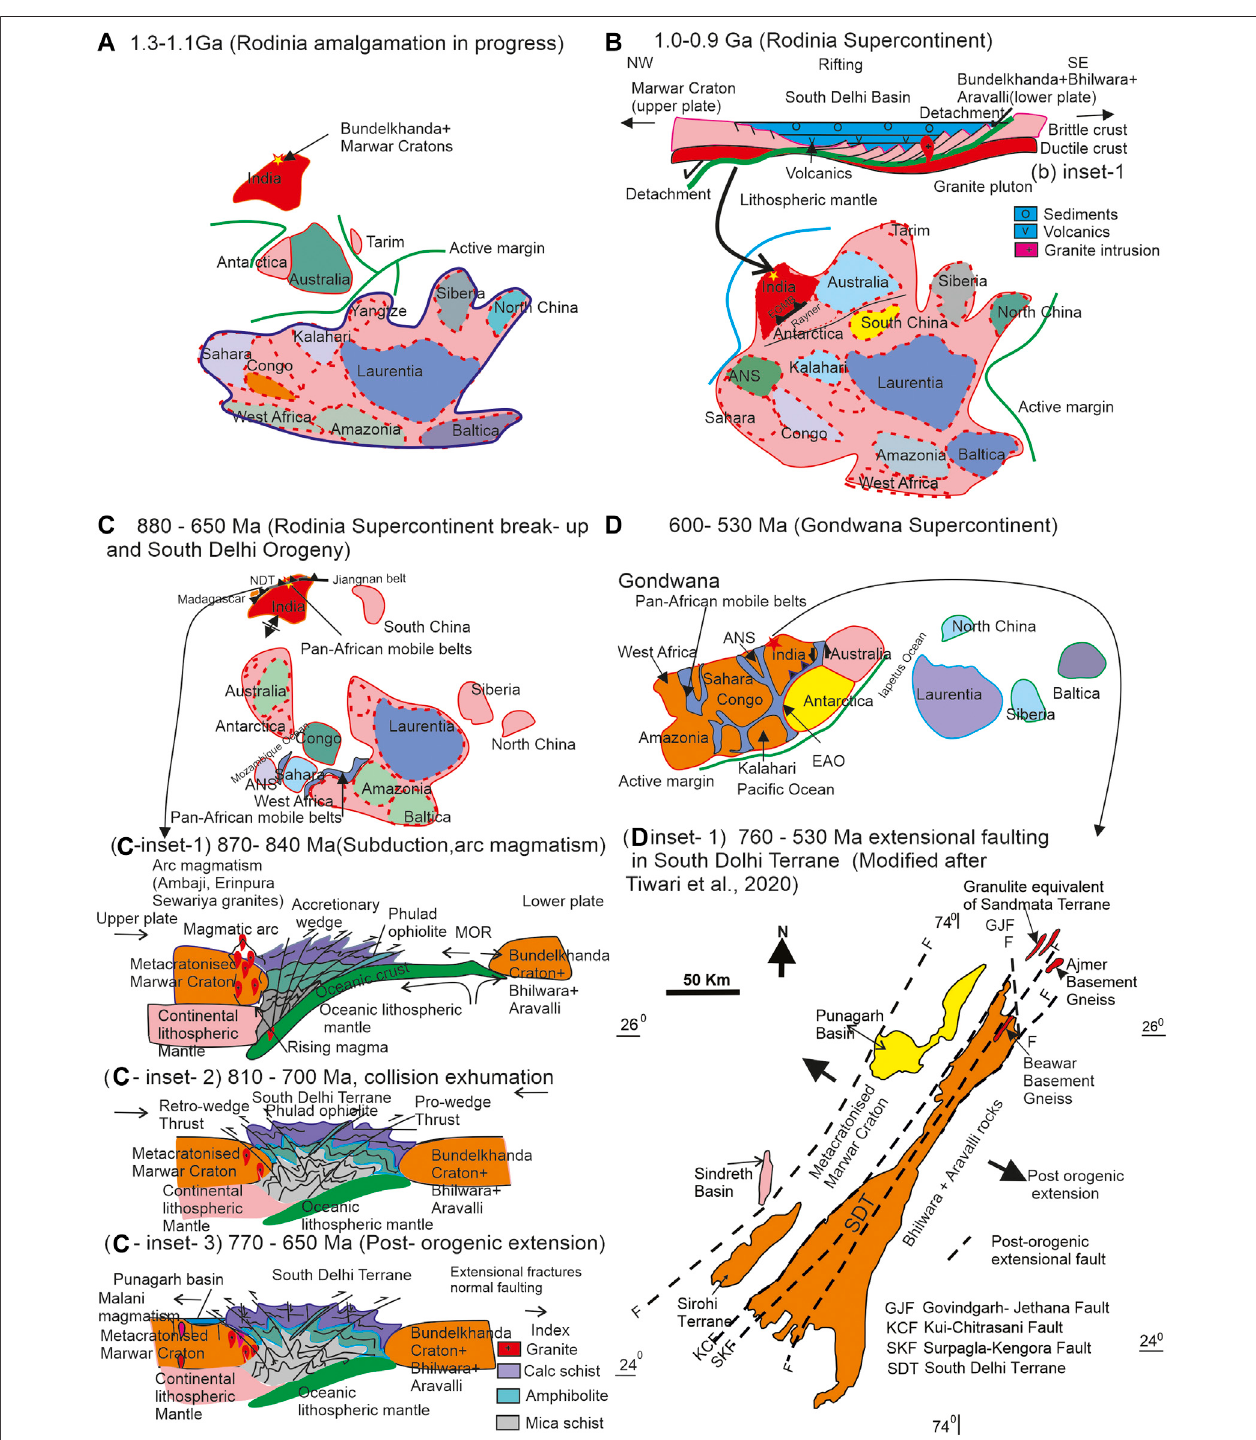
FIGURE10| CartonsshowingpositionofIndia duringcontinental assembly andbreakup. (A) 1.3 – 1.1 Ga,Rodinia wasunderamalgamation; Indiaseparatedfrom Baltica, drifted to join Antarctica and Australia. (B) East Gondwana continents amalgamated to complete Rodinia assembly by 1.0 Ga. Eastern Ghats Mobile Belt developedintheSEmarginofIndiabysubduction/collisionbetweenIndiaandAntarctica.Synchronously,theNWmarginofIndiaunderwentinternalriftingthatledtothe formationofSouthDelhibasin.Asimpleshearmodelhasbeenproposedforbasinopening( Figure 10B ,inset1)(e.g.,Wernicke,1985,modeldrawncf.;Allenand Allen, 2013). The sediments were laid down with a prominent erosional unconformity over granitic basement, marked by conglomerate and paleosol. Further, bimodal volcanism (982 Ma) occurred and granite plutons (992 – 946 Ma) intruded in the basin, (C) Ca 880 Ma, Rodinia broke up; East Gondwana continents were drifted apart.